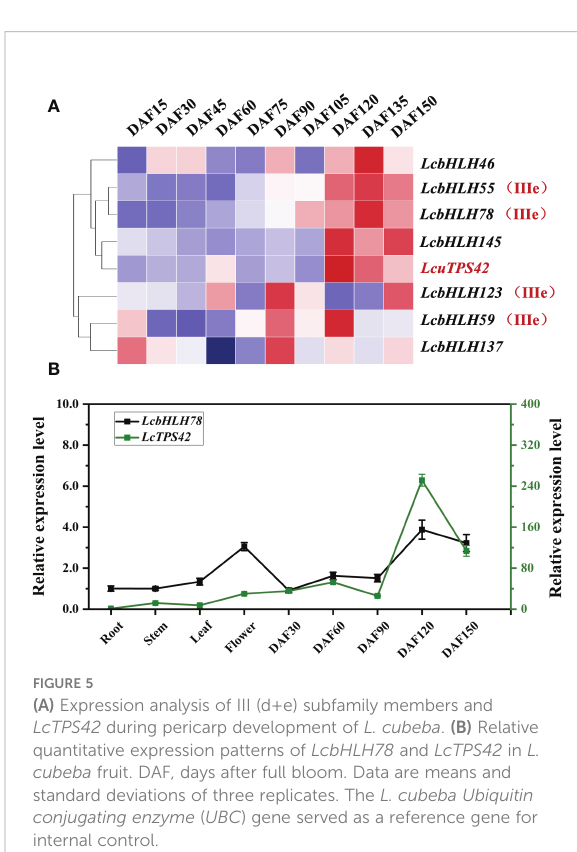
FIGURE 5 (A) Expression analysis of III (d+e) subfamily members and LcTPS42 during pericarp development of L. cubeba . (B) Relative quantitative expression patterns of LcbHLH78 and LcTPS42 in L. cubeba fruit. DAF, days after full bloom. Data are means and standard deviations of three replicates. The L. cubeba